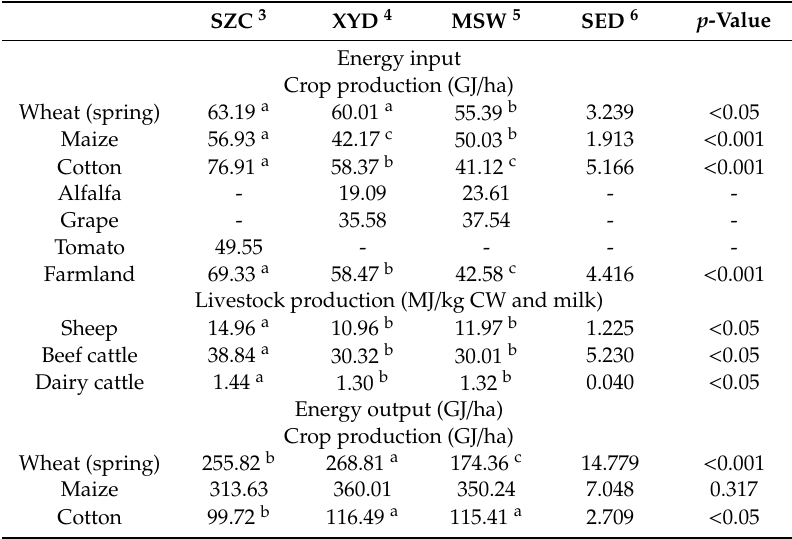
Table 4. Energy balances, net energy ratio, and water use e ffi ciency of agricultural production in the Shihezi sub-oases.